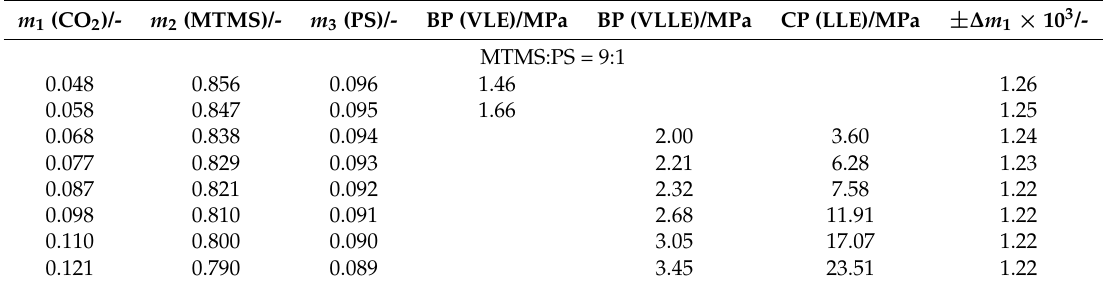
Table 3. Experimental data for a CO 2 (1)/MTMS(2)/PS(3) system (M W = 35,000, 353.2